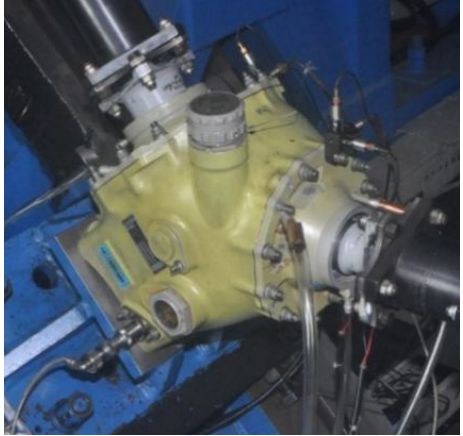
Figure 1. Operation test of double-row TBRs after oil loss. After 40 min of the reducer operation, the disassembling inspection found that the double-row TBR with the outer ring rib structure was working normally without obvious failure. For the bearing with the inner ring rib structure, the cage turned black, a crack appeared at the spacer beam of the large roller cage, and the small roller cage fractured, as shown in Figure 2. The double-row TBR with the outer ring rib structure exhibits better oil retaining capacity than that with the inner ring rib structure, and its dry running ability is also stronger in the oil loss state. These observations are consistent with the simulation analysis results of this